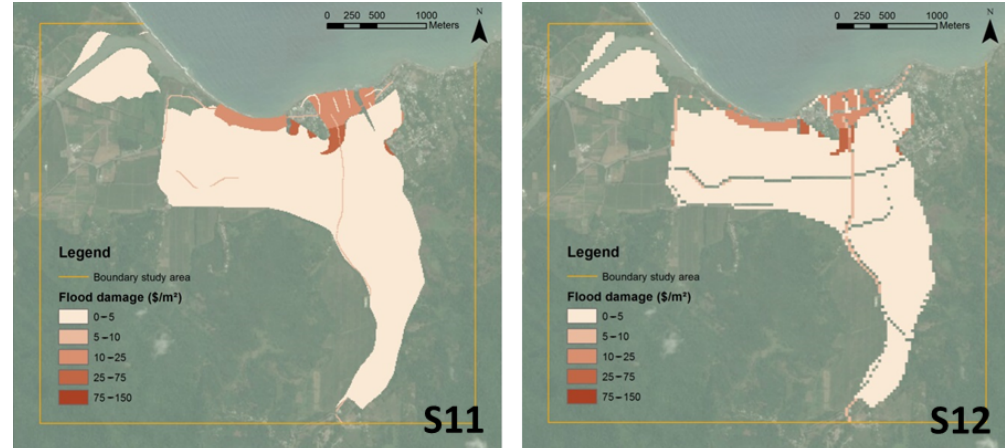
Figure 8. Damage maps for Annotto Bay for S11 and S12. Left: (S11) raster approach (10 × 10) based on population density. Right: (S12) raster approach (30 × 30) based on population density.